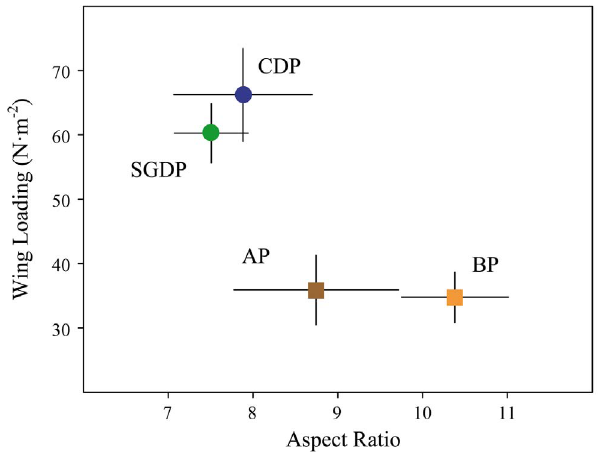
Figure 10. Flight performance descriptors. Mean 6 SD of wing loading and aspect ratio of four species of small petrel measured during incubation at Bird Island, South Georgia in summer 2010/11. Species abbreviations: AP (Antarctic prion), BP (blue petrel), CDP (common diving petrel) and SGDP (South Georgian diving petrel). All n=15.